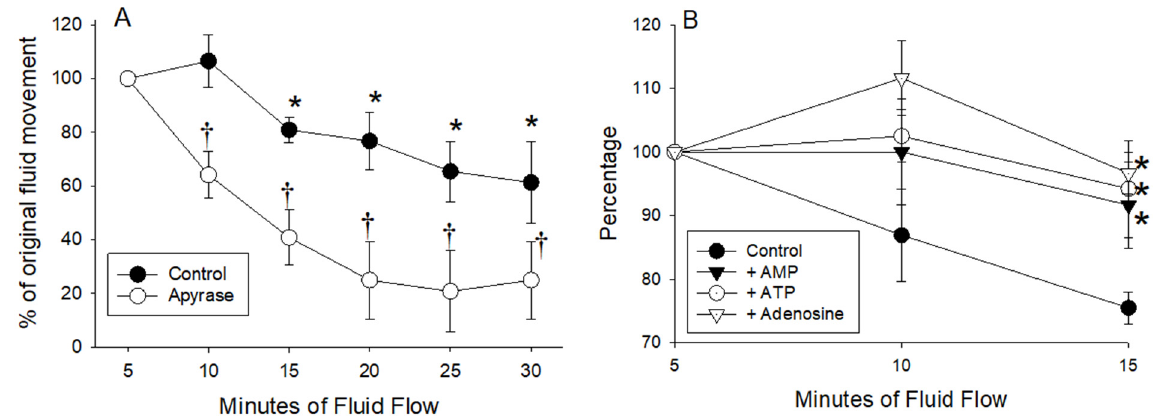
Figure 10. ( A ) Enterocytes harvested from two mice were cultured on inserts ( n = 6 per mouse) and fluid flow in the presence and absence of apyrase was recorded for six consecutive 5 min periods with vigorous aeration. Fluid levels were equilibrated between each 5 min period. Values are expressed as a percentage of the fluid movement recorded for the first 5 min interval before the addition of apyrase. Differences are indicated for comparisons with initial readings (*) and for comparisons with and without apyrase (†). ( B ) The decline in rates of flow by control inserts were slowed by the addition of 0.5 mmol ATP, AMP and adenosine to both chambers. Values are expressed as the percentages of initial values. (* p < 0.05 for comparison with control tissues not exposed to ATP, AMP, or adenosine).